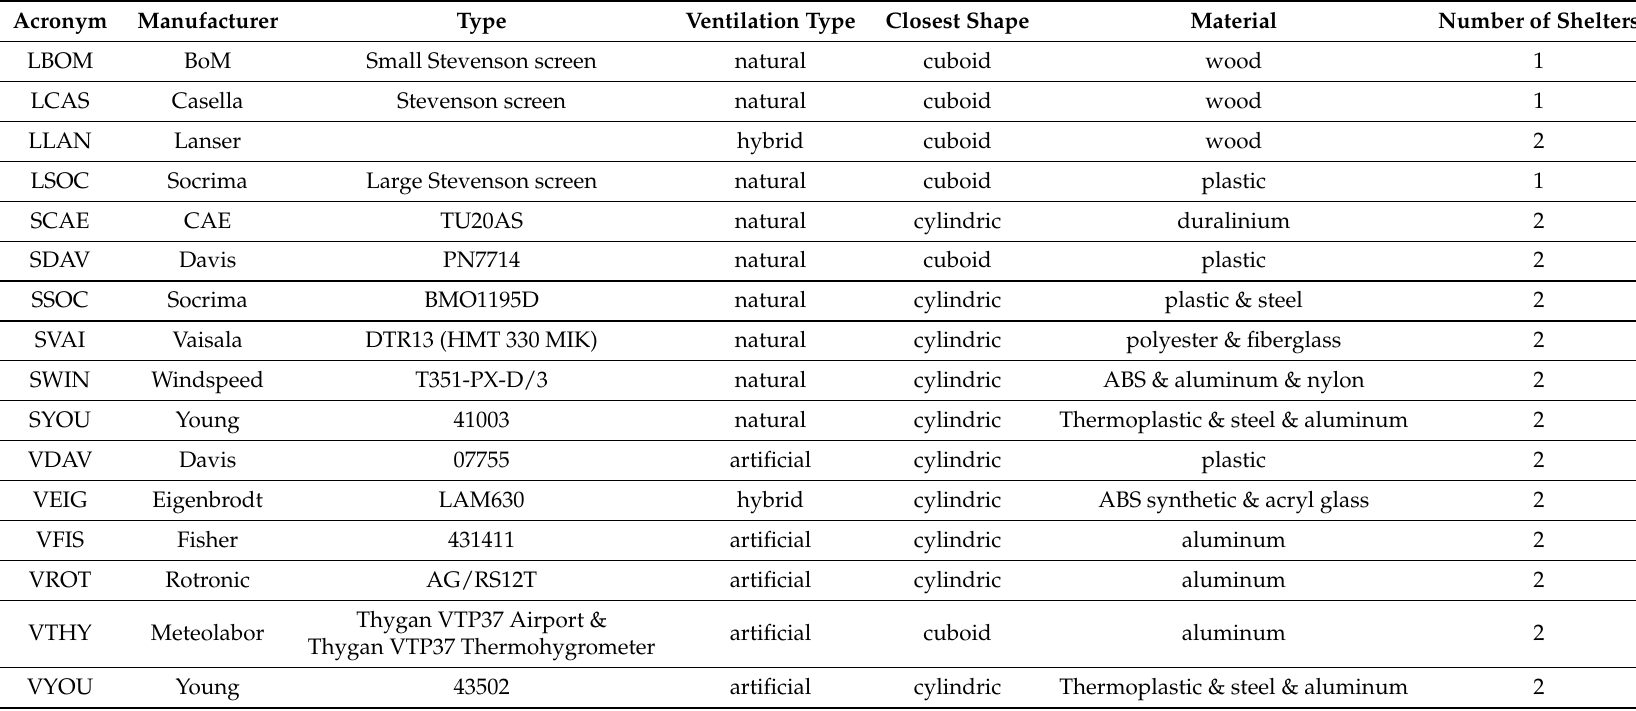
Table A1. Main Informations Concerning the 29 Shelters Used during the WMO